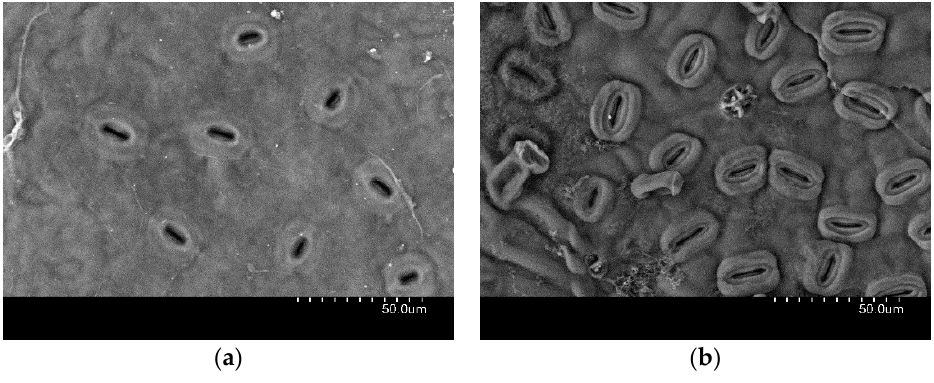
Figure 5. Stomatal density of ( a ) Q. coccifera and ( b ) Q. faginea .